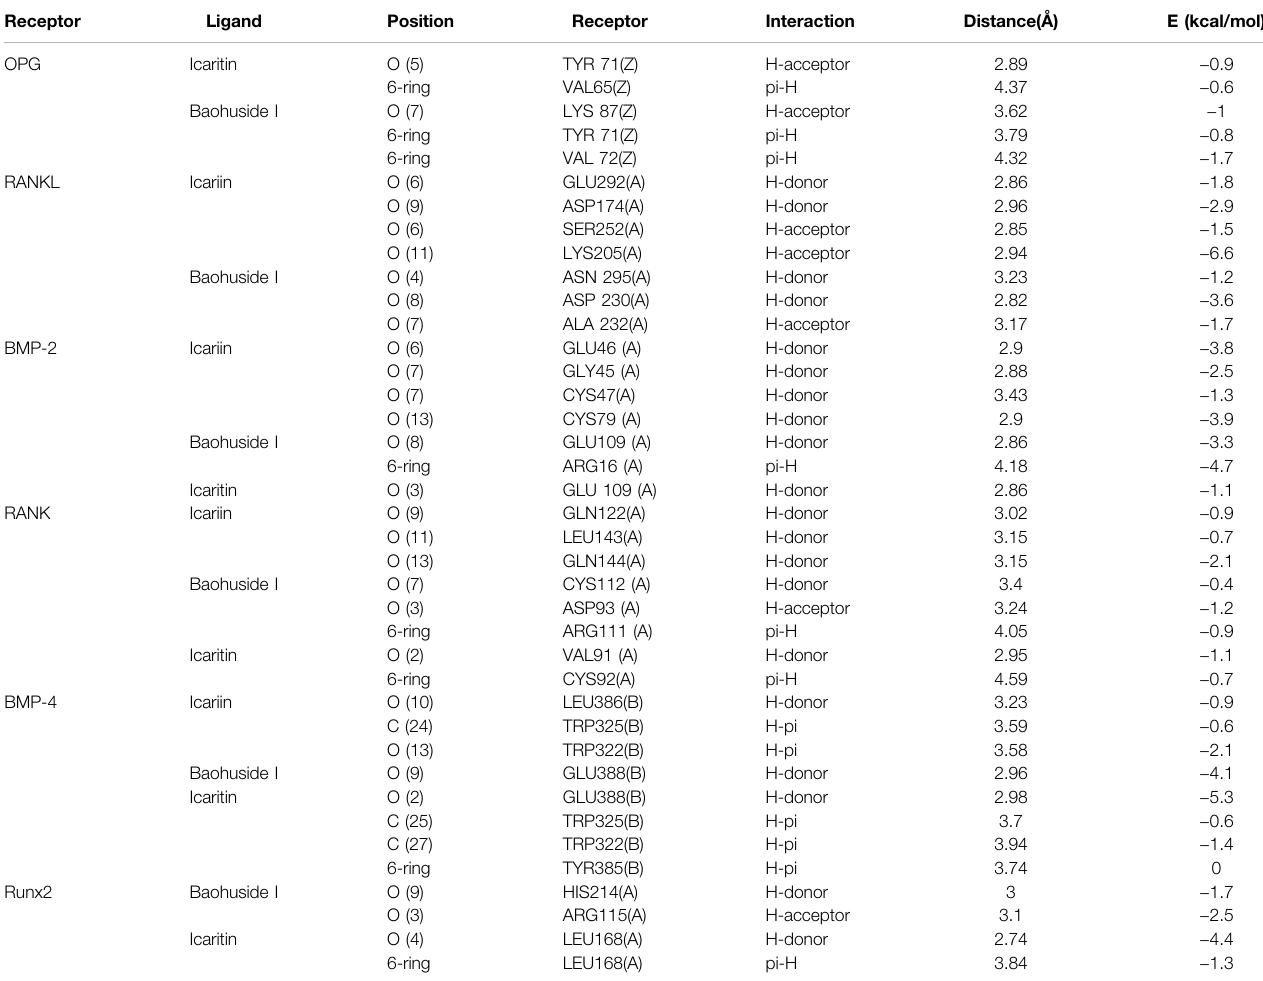
TABLE 3 | Bonding energy, binding position, H-bond interaction between receptors and ligands. Receptor